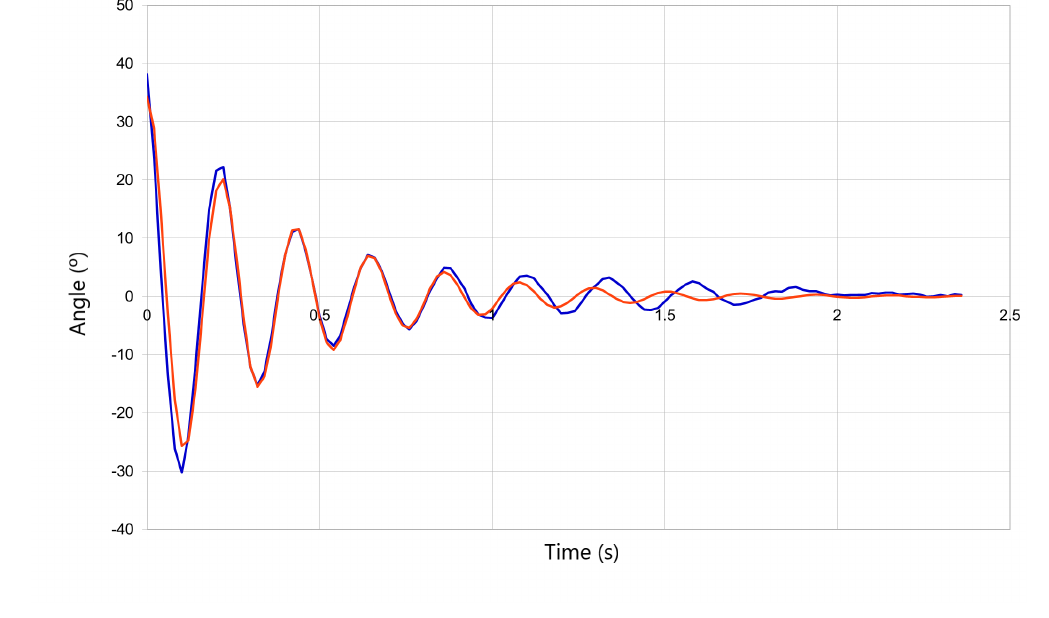
Figure 14. Plot of Angle vs. Time.